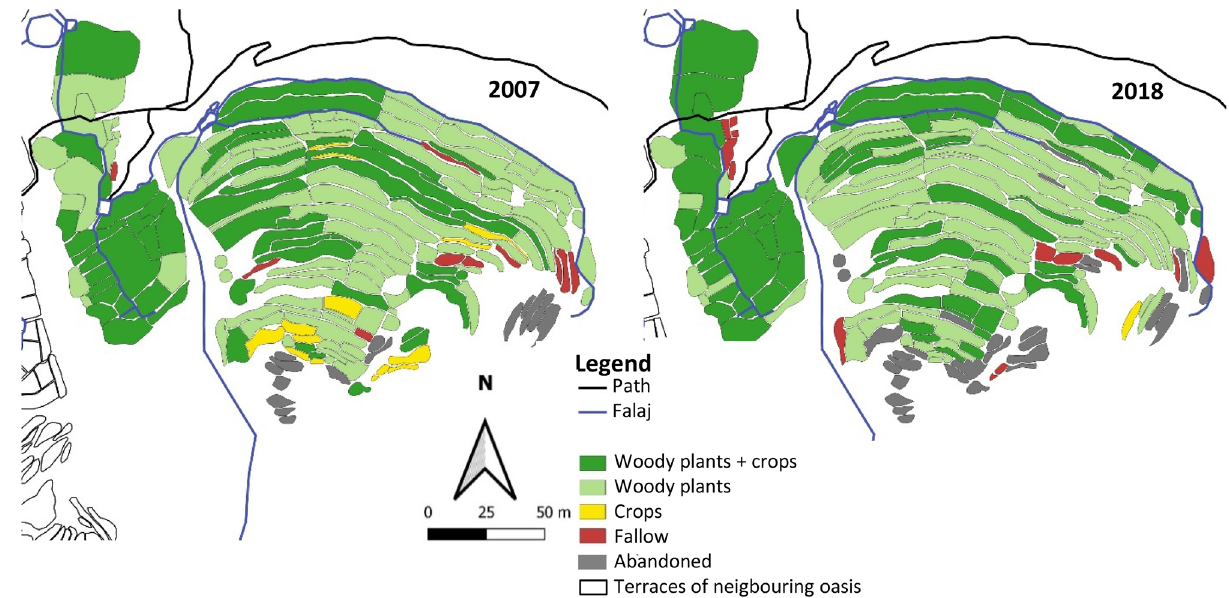
Figure 5. Landuse map of the oasis Al ‘Aqr (1,950 m a.s.l.) in Wadi Muaydin (Al Jabal Al Akhdar, Oman) in 2007 and